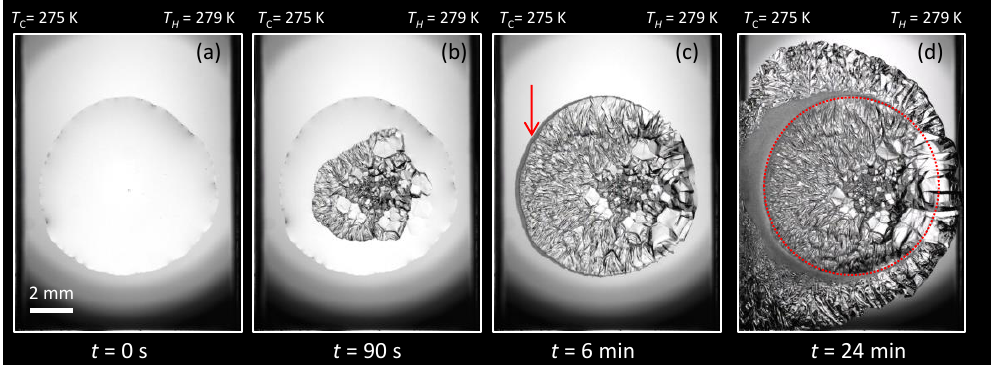
Figure 3. Methane hydrate formation and growth on an aqueous MEG solution droplet subject to a temperature gradient. The temperature gradient increased from T L = 275.0 K (left) to T H = 279.0 K (right). w EG = 10%, p = 5.99 MPa, T HLV = 279.7 K. ( a ) Aqueous MEG solution droplet before hydrate formation. ( b ) Initial growth points moving to the center of the droplet and continued growth of hydrate film. ( c ) Droplet is completely covered by hydrate. The red arrow points to the initial halo growth. ( d ) The dotted line marks the original droplet boundary. Hydrate halo propagates from the original water boundary toward both the high driving force end of the slide and toward the low driving force